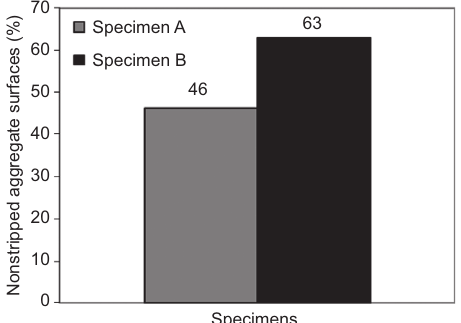
Figure 3 Nicholson stripping test results.